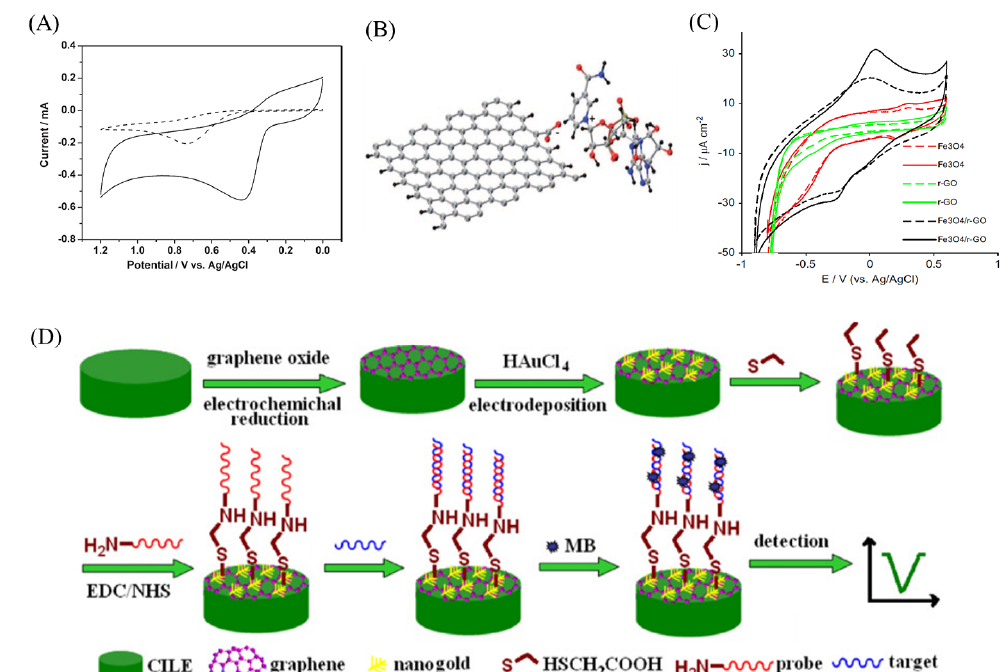
Figure 4. ( A ) Cyclic voltammetric responses of the bare GC (dashed line) and rGO-based GC (solid line) in 0.1 M PBS (pH 6.8) PBS containing 1 mM NADH. ( B ) Graphene edge terminated by hydrogen atoms and containing one -COO- group. ( C ) Electrochemical responses of Fe 3 O 4 /GC, r-GO/GC and Fe 3 O 4 /r-GO/GC electrodes in 0.1 M PBS (pH 7.0) and scan rate 20 mV s − 1 in the absence (dashed line) and presence (solid line) of 0.5 mM NADH. ( D ) Schematic representation of the electrochemical